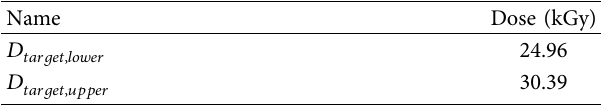
Table 4: Limit values of the dose range for the monitoring do- simeter for routine dosimetry.